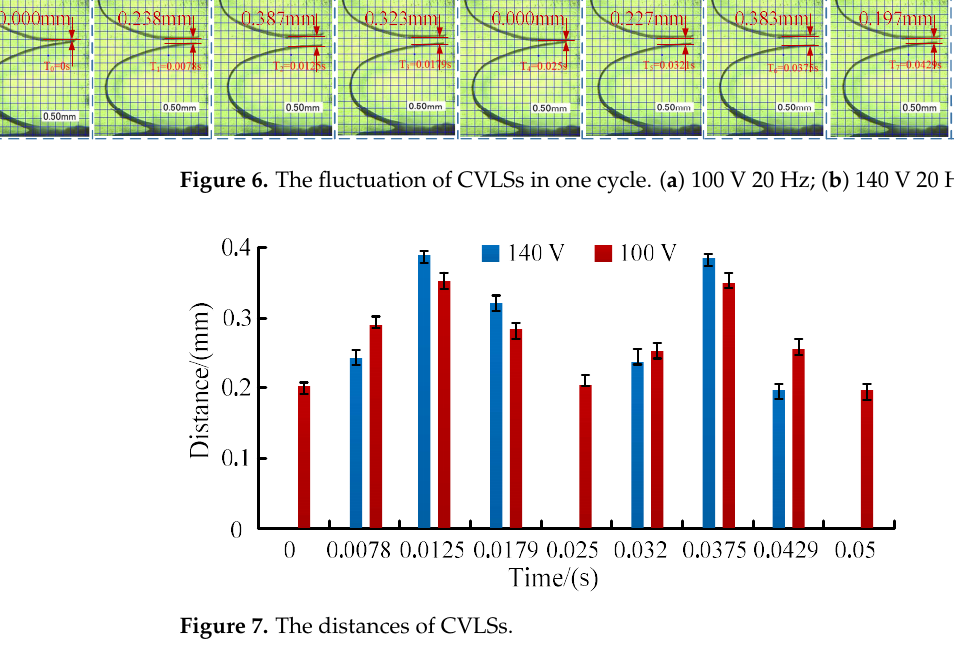
Table 1. The mechanical properties of the transparent SLA photosensitive resin.